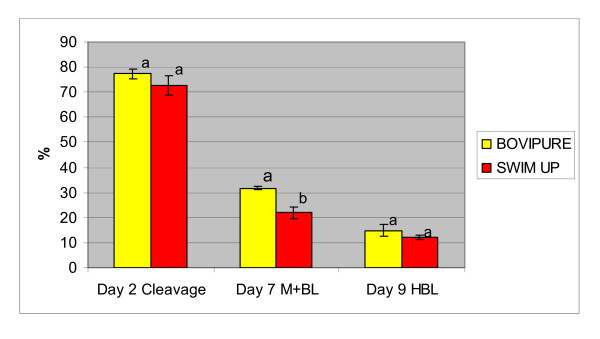
Cleavage, blastocysts and hatched blastocysts rates for BoviPure® and swim up (mean ± S.E.M.), Values with different superscripts within the same columns differ significantly (P < 0.05)